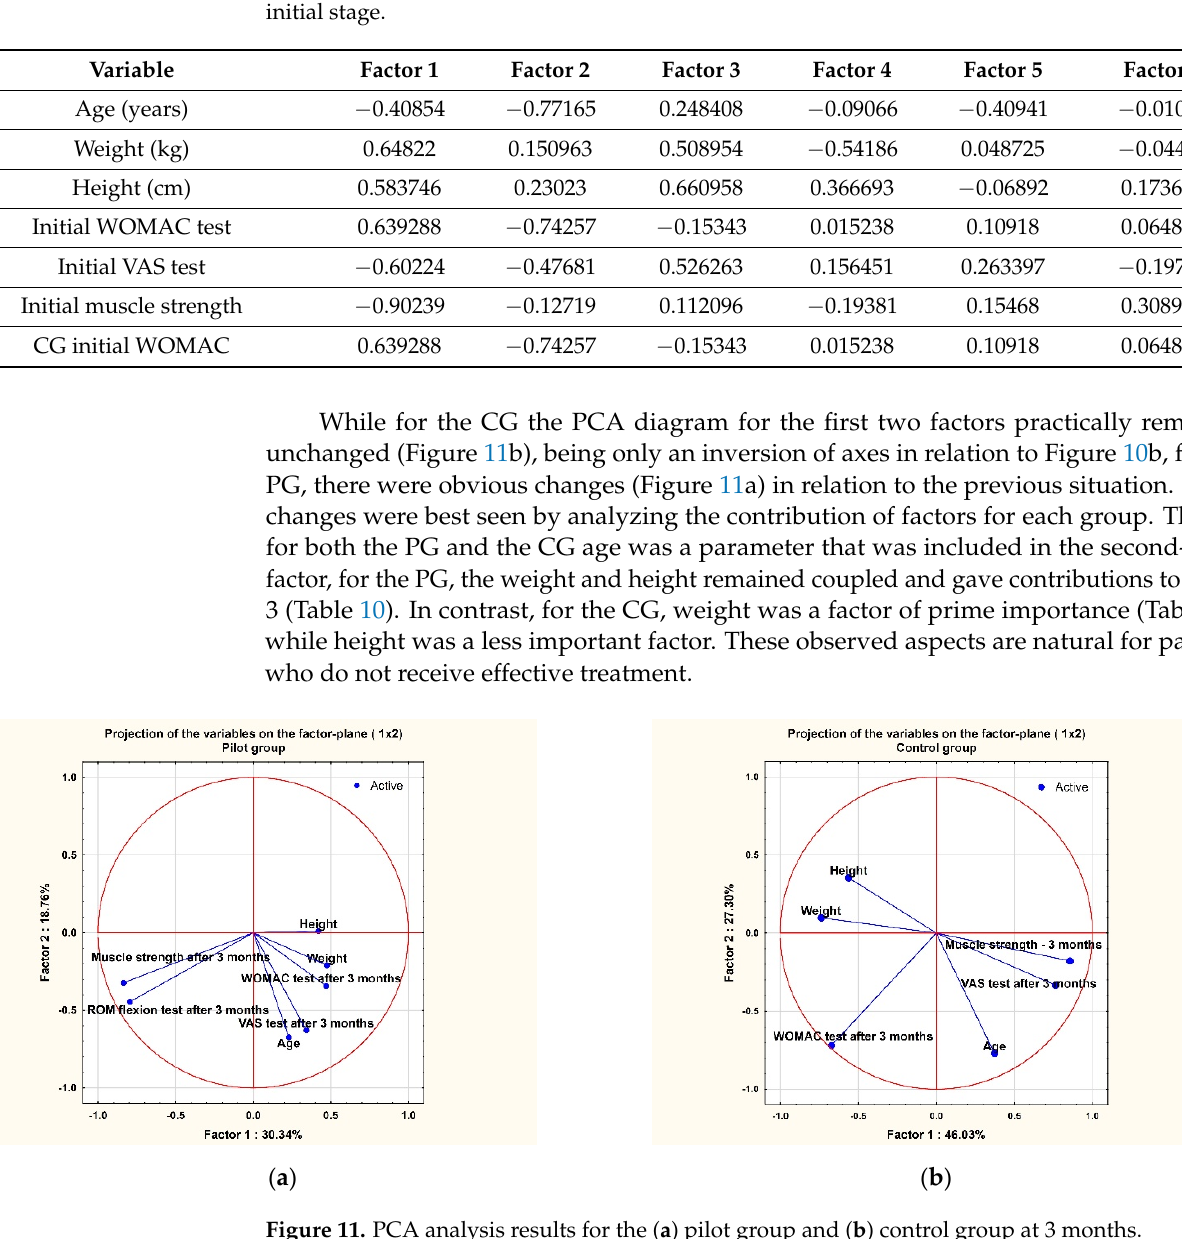
Figure 11. PCA analysis results for the ( a ) pilot group and ( b ) control group at 3 months. Table 10. Factor coordinates of the variables based on correlations for the pilot group (PG) after 3 months.